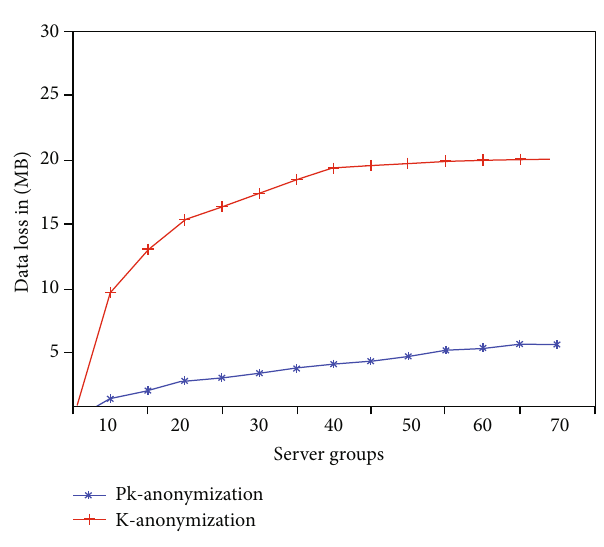
Figure 8: Data lost rate.